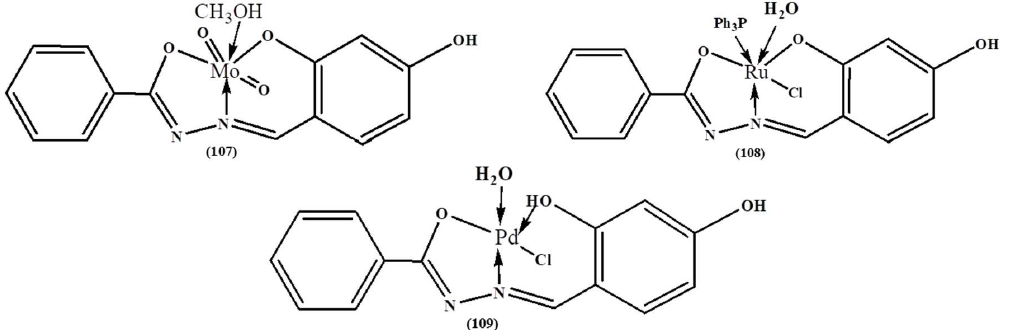
Figure 14. Structure of the prepared H 2 dhbh complexes (103–109). Reproduced from the permission of ref. [159].